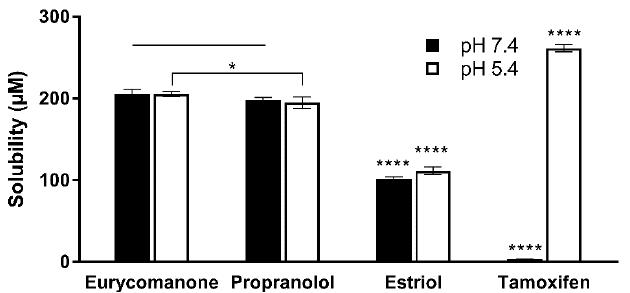
Figure 3. Aqueous solubility of eurycomanone, propranolol, estriol, and tamoxifen at pH 7.4 and pH 5.4. The values were plotted based on the mean ± standard deviation. **** denotes significant difference when compared to eurycomanone ( p ≤ 0.0001) at the two pH values. * denotes significance difference between propranolol and eurycomanone at pH 5.4 ( p ≤ 0.05). Line over bars indicates no significant difference when compared to eurycomanone ( p ≥ 0.05).